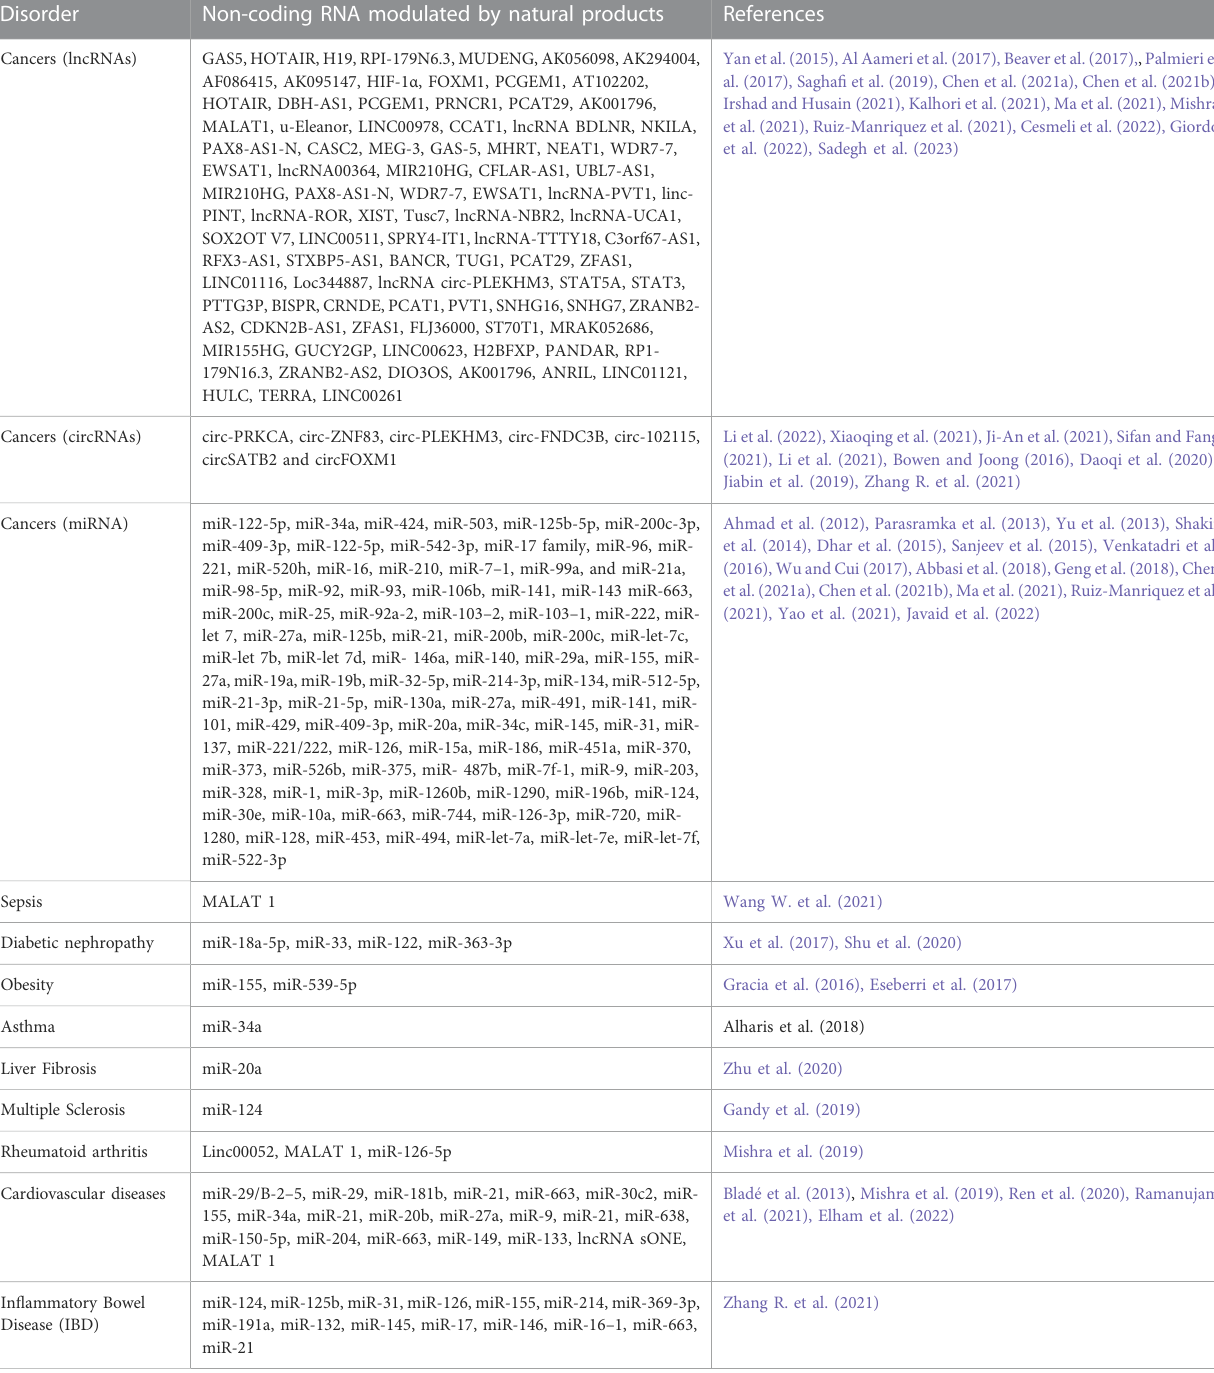
TABLE 1 Non-coding RNAs modulated by Natural Products in Oxidative Stress and In fl ammation Related Disorders Disorder Non-coding RNA modulated by natural